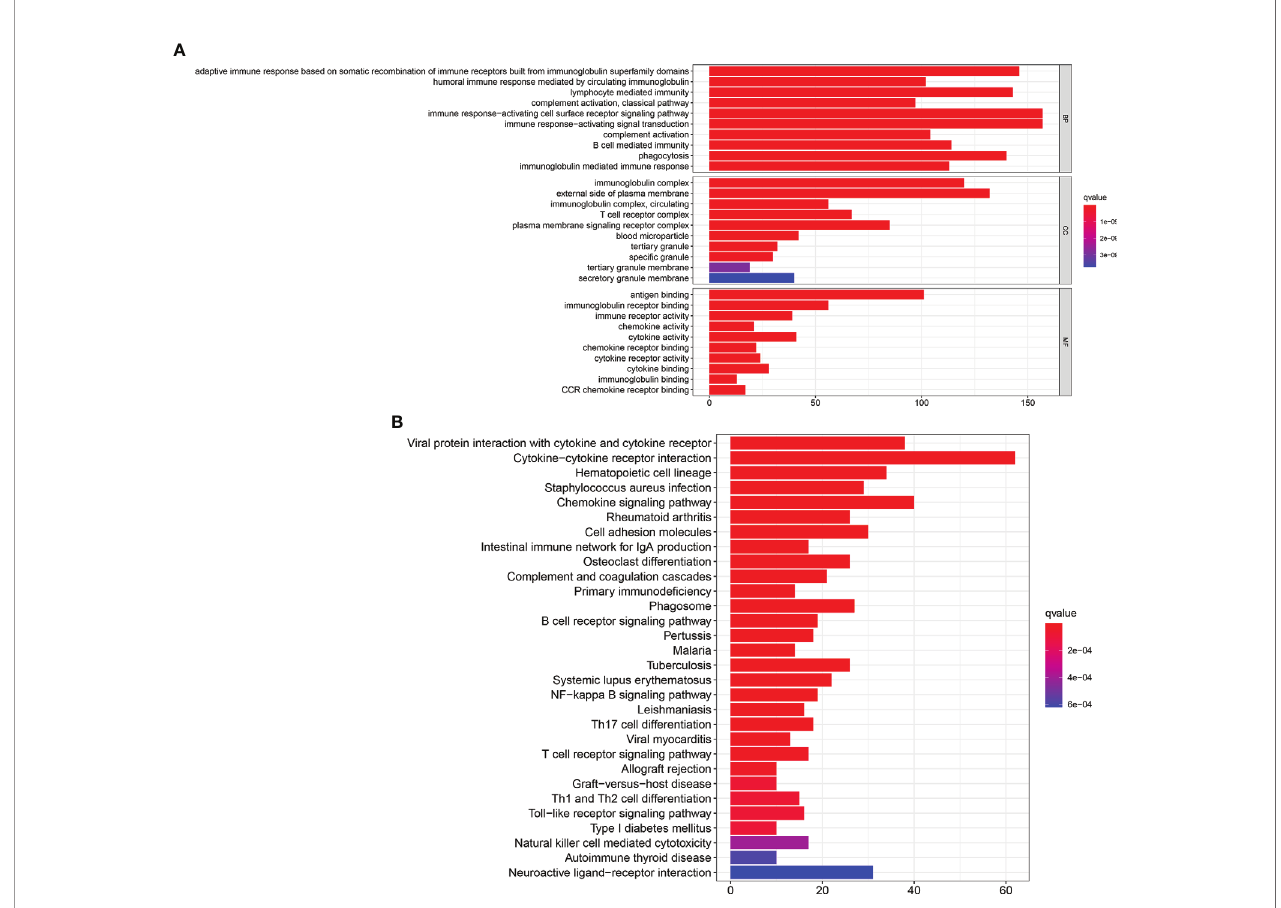
FIGURE 4 | GO and KEGG enrichment analyses. (A) GO enrichment analysis for 1,097 DEGs, only both p and q < 0.05 were considered signi fi cant. (B) KEGG pathways enrichment analysis for 1,097 DEGs, only both p and q < 0.05 were considered signi fi